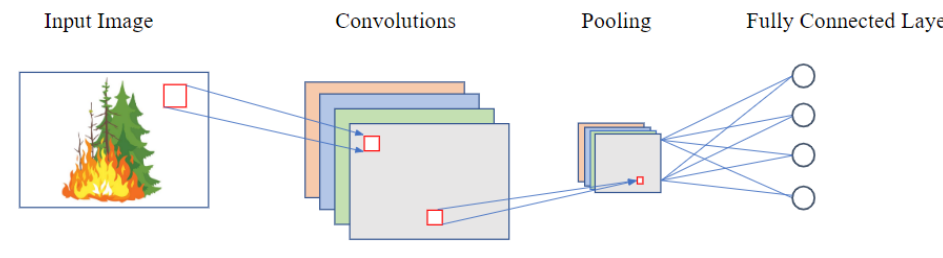
Figure 1. Graphical depiction of a CNN.